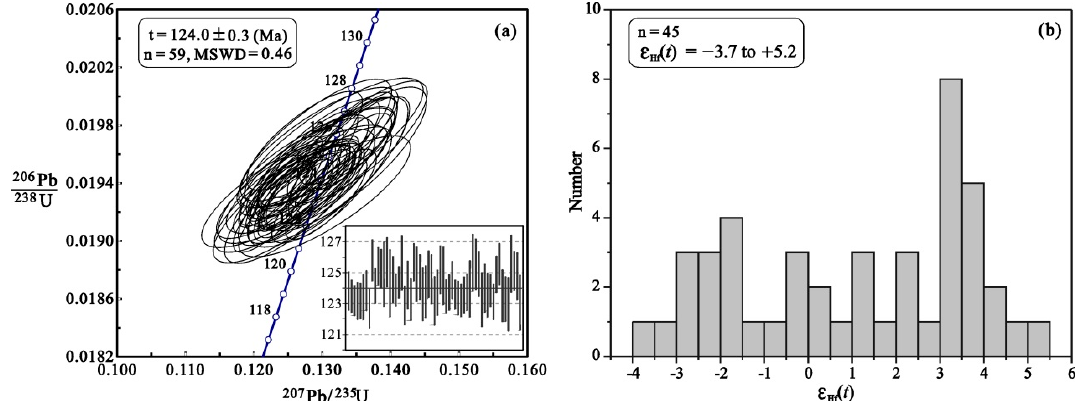
Figure 4. Zircon U ‐ Pb concordia diagram and 206 Pb/ 238 U weighted mean ages ( a ) and probability histogram of ε Hf ( t ) values ( b ) for the granodiorite.